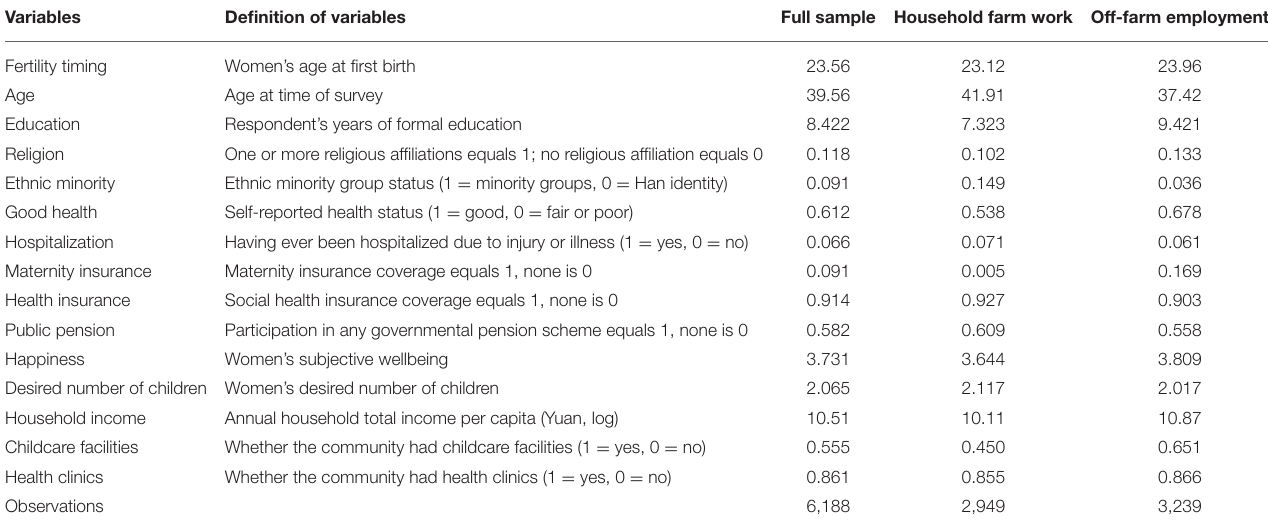
TABLE 1 | Definition of variables and mean for the full sample and by working